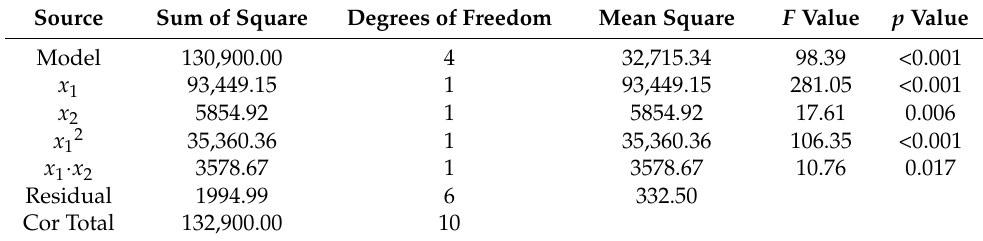
Table 6. ANOVA for machining energy consumption ( E 2